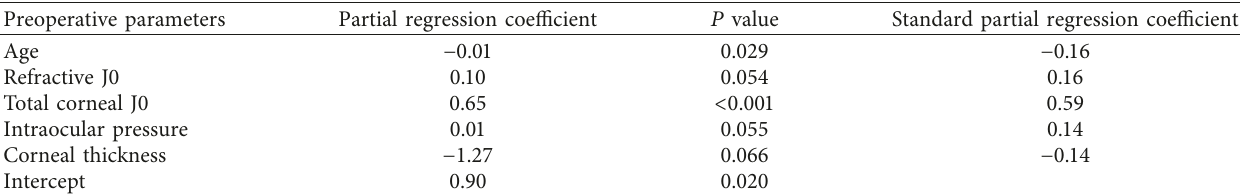
Table 2: Multivariate regression analysis of postoperative refractive J0.